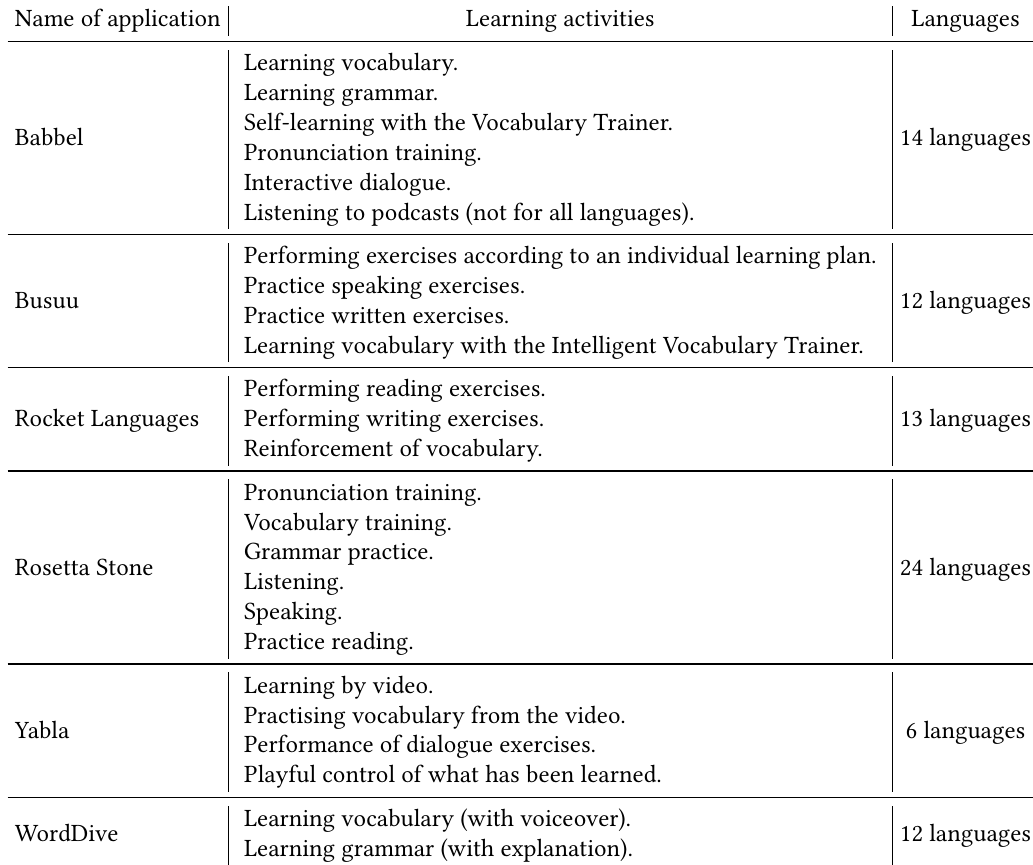
Table 3 Comparison of selected mobile language learning applications